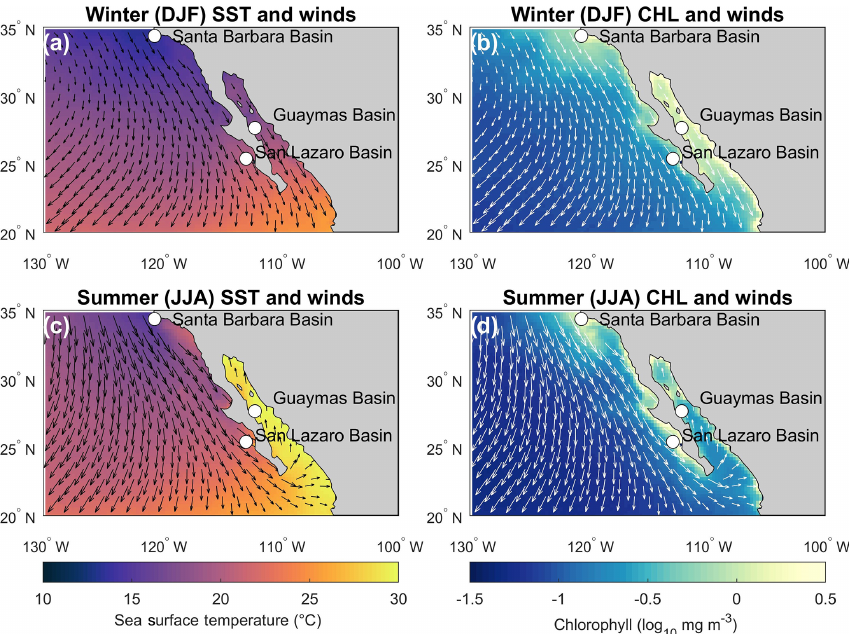
Figure 1. (a) Winter (December, January, February) sea surface temperature average and wind pattern; (b) winter chlorophyll monthly average and wind pattern; (c) summer (June, July, August) sea surface temperature average and wind pattern; (d) summer chlorophyll monthly average and wind pattern. The basins highlighted are where high-resolution (subdecadal) sediment cores were previously retrieved and